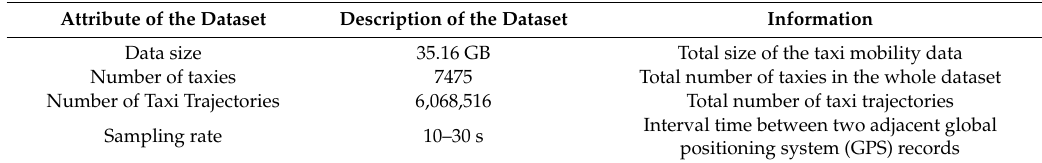
Table 1. Data description for Shenzhen taxi mobility data.